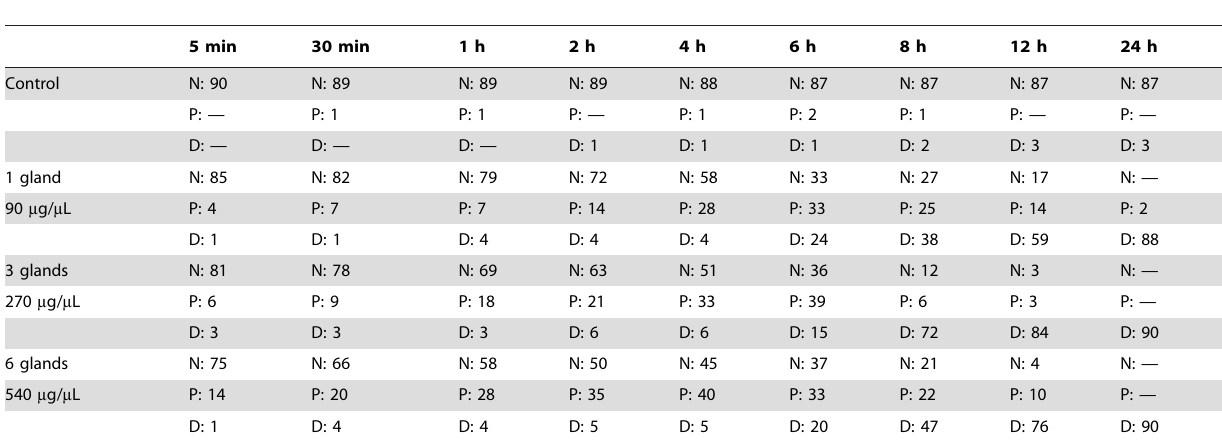
The doses correspond to the equivalent of one, three or six Dufour gland extracts (N: normal state of the termites that are active; P=paralysis; D: Death). Statistical comparison. Friedman x 2 =20.8; df=3; P=0.00011; Post-hoc tests; control vs . 1 gland: NS; control vs . 3 glands: P=0.0011; control vs . 6 glands: P=0.0002.